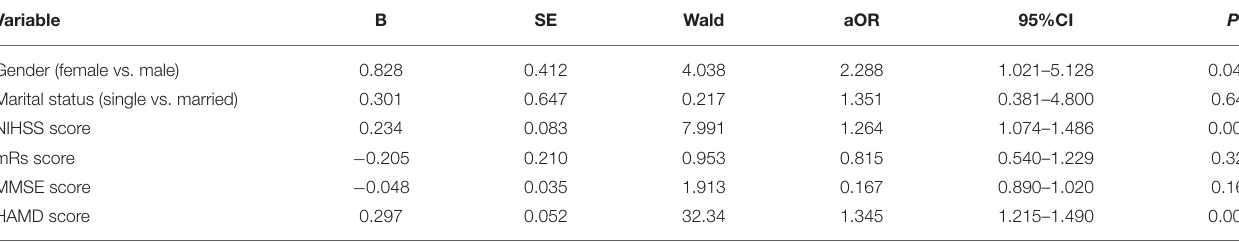
TABLE 2 | Multivariate logistic regression analysis for identification of factors associated with PSA in elderly patients. Variable B SE Wald aOR 95%CI P Gender (female vs. male) Marital status (single vs.